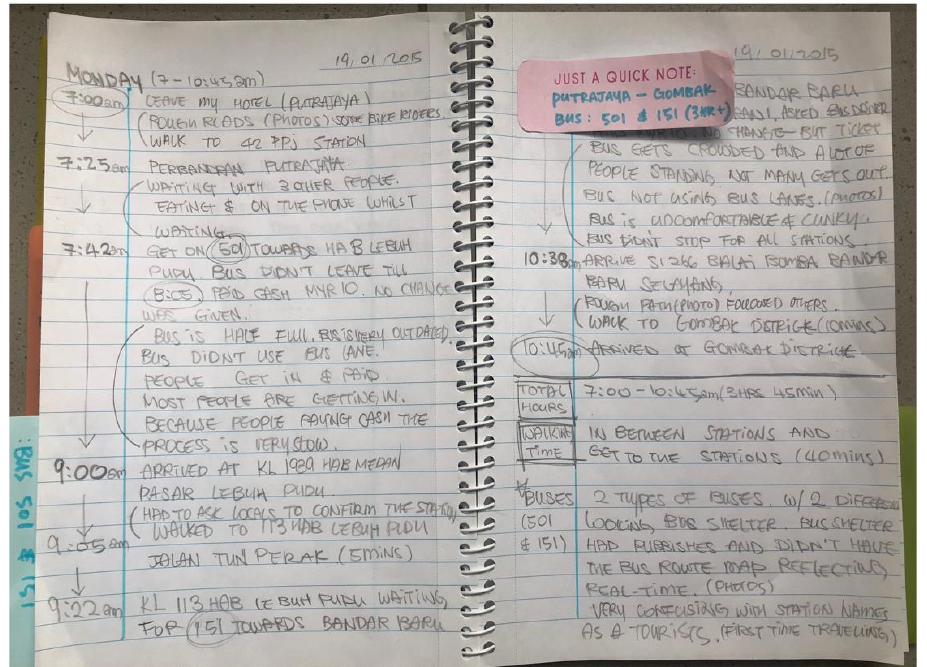
Figure 1. Field notes for user observation.